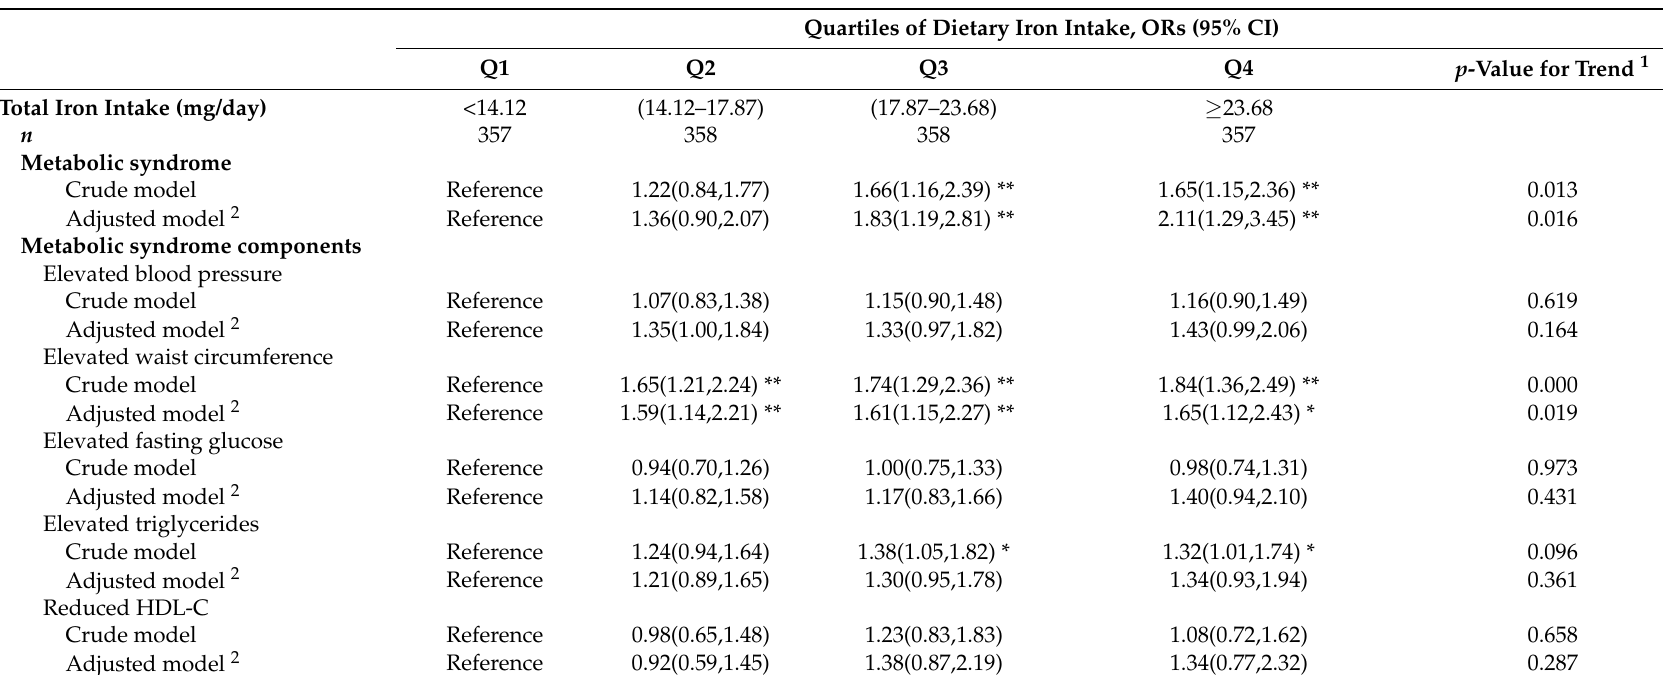
Table 5. ORs (95% CI) for metabolic syndrome and its components according to the quartiles of total iron intake (mg/day) among men in the SDHS 2012–2013. Quartiles of Dietary Iron Intake, ORs (95%